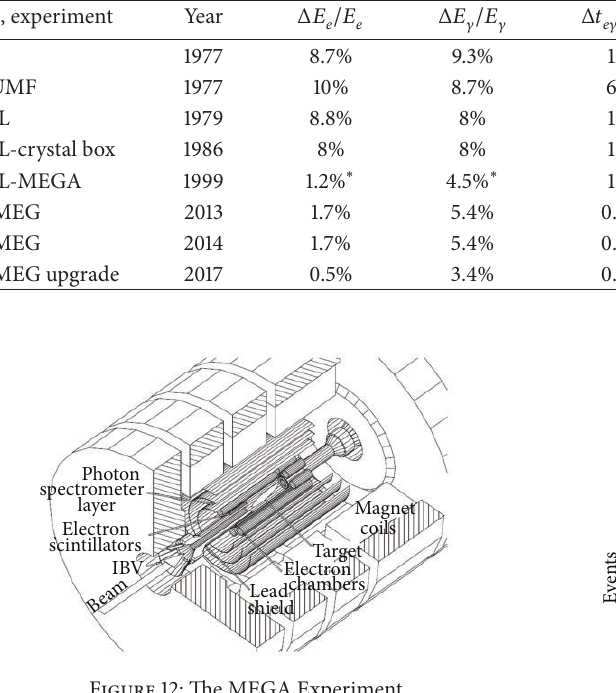
Table 2: The performances of recent 𝜇 + → 𝑒 + 𝛾 experiments, compared with the best limit set by MEG [92] and the expected sensitivy obtainable at the end of MEG running and (later on) of its upgrade stage [94]. All quoted resolutions are FWHM. ∗ shows an average of the numbers given in [88, 89]; ∗∗ is the predicted 90 % C.L. sensitivity.